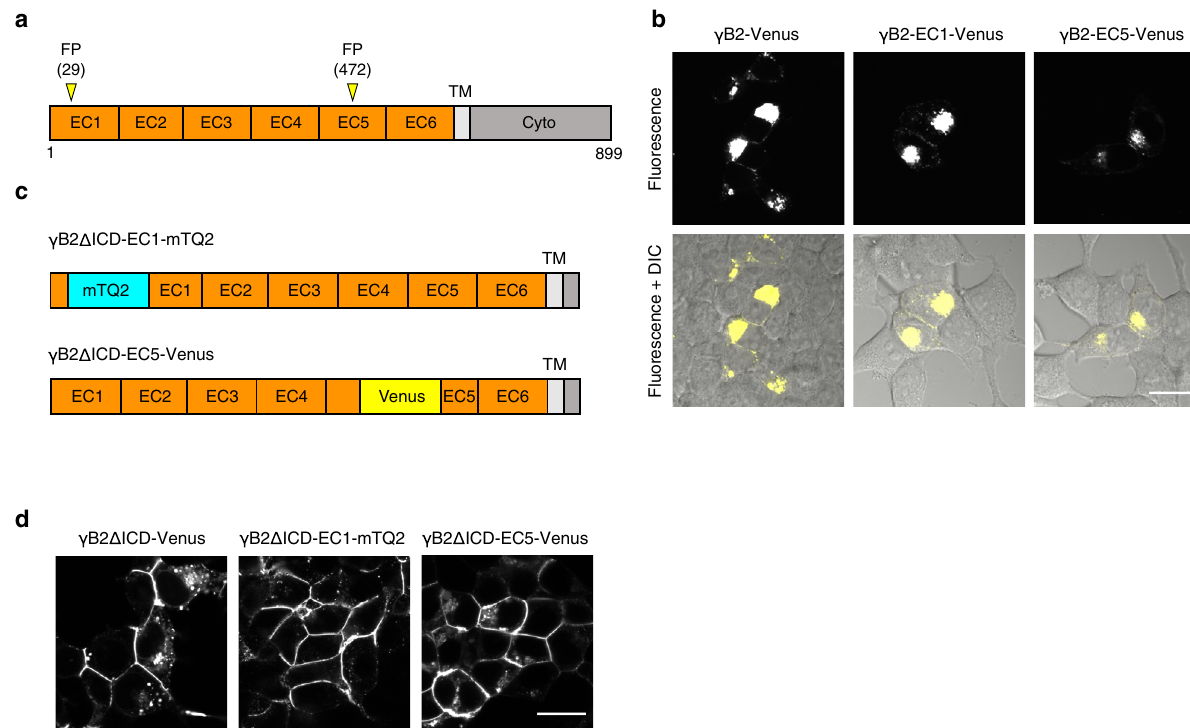
Figure 1. Molecular design and cellular localization of FP-inserted γB2. ( a ) Schematics of full-length protocadherin-γB2 (γB2). γB2 is represented as serially repeated extracellular domains (EC domains), a transmembrane region (TM), and a cytoplasmic region (Cyto). The insertion positions (amino acid position 29th and 472nd residues in the matured form) of fluorescent protein (FP) are indicated by yellow arrowheads. ( b ) The localization of Venus-inserted γB2 constructs in HEK293T cells. HEK293T cells expressing the indicated constructs were observed using a confocal microscope. Fluorescence images (upper) and merged fluorescence and differential interference contrast (DIC) images (lower) are shown. Scale bar, 20 μm. ( c ) Schematics of FP-inserted γB2ΔICDs. In γB2ΔICD-EC1-mTQ2 and γB2ΔICD-EC5-Venus, mTurquoise2 (mTQ2) and Venus are inserted in γB2ΔICD at the positions as indicated in (a). ΔICD denotes deletion of an intracellular domain (ICD), which leads to efficient localization of γB2 at the plasma membrane. ( d ) The localization of FP-inserted γB2ΔICDs in HEK293T cells. HEK293T cells expressing the indicated constructs were observed using a confocal microscope. Scale bar, 20